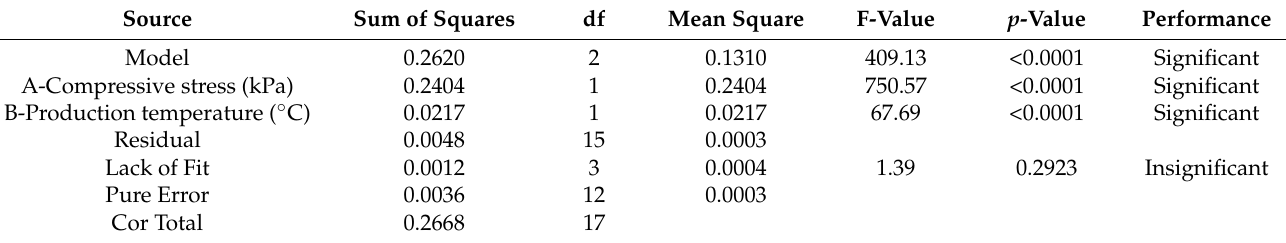
Table 9. ANOVA for the linear